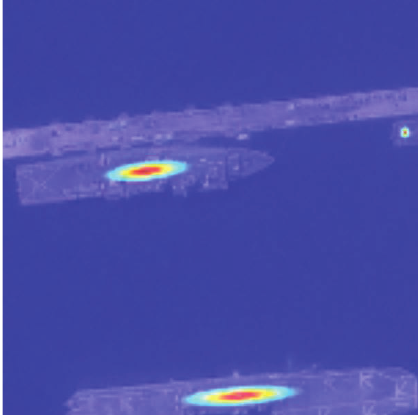
Figure 5. The adaptive Gaussian heatmap generated by the adaptive Gaussian